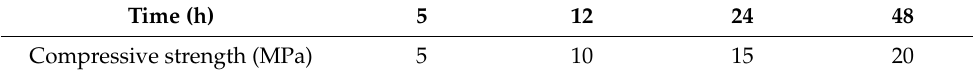
Figure 7. Backwall filling compaction control scheme. Table 3. Correlation of filling material’s curing time with the sample